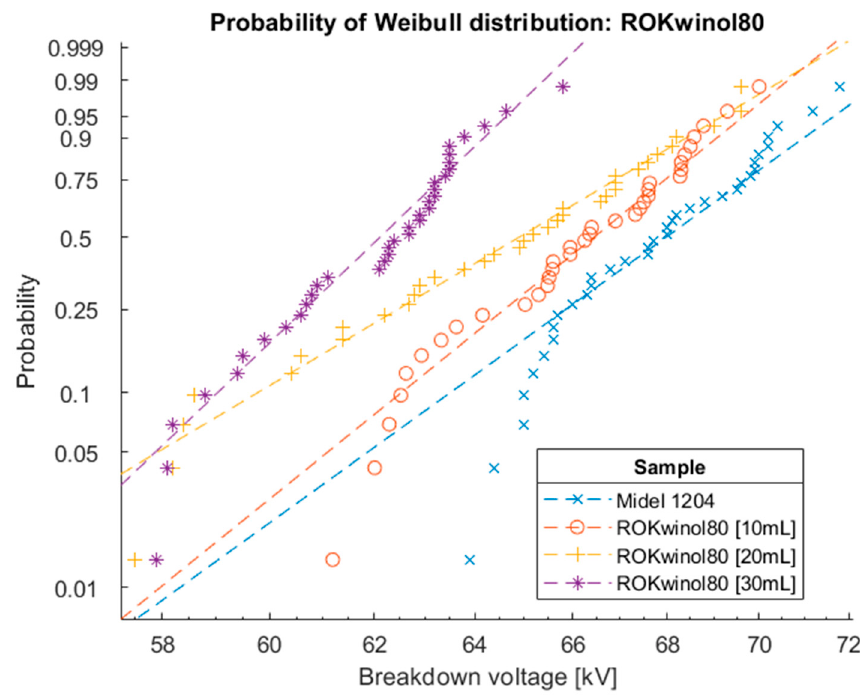
Figure 16. Cumulation distribution functions for Weibull distribution of oil Midel 1204 with different concentrations of surfactant ROKwinol80.